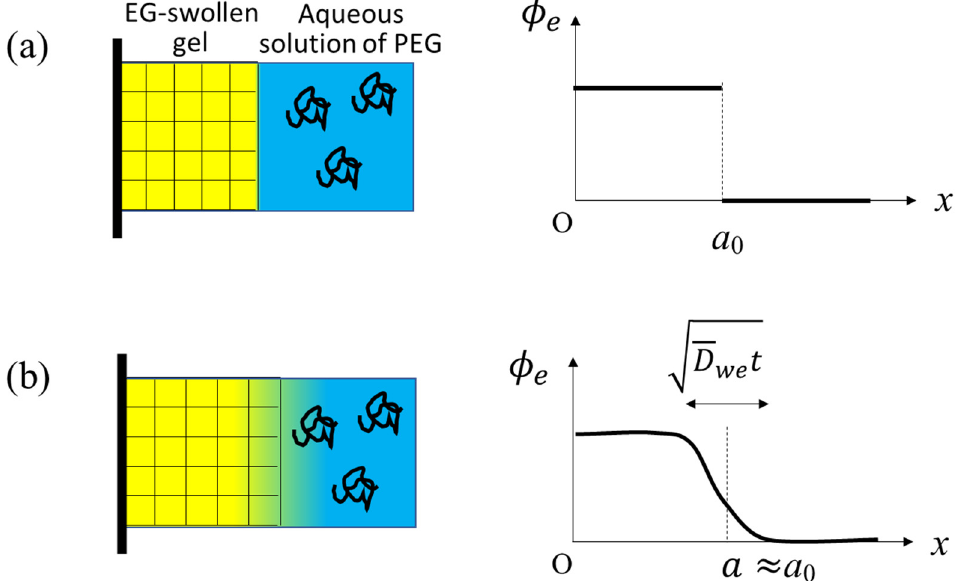
Figure 1. ( a ) A schematic representation of the system at the initial state of t = 0 ( left ) and the initial profile of the volume fraction φ e of EG, ethylene glycol ( right ). In the left illustration, the yellow and blue regions represent EG and water, respectively, and the random coils represent PEG chains. ( b ) A schematic representation of the gel ( left ) and a slightly smoothed profile of φ e ( right ) at a time t during the early stage of the solvent exchange when the mixing of EG and water occurs locally and vigorously around the gel surface. D we is a typical value of D we ( φ e ) around the gel surface.